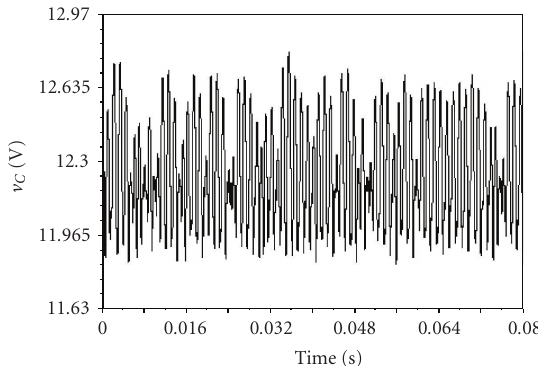
Figure 8: 2- T subharmonic operation. ( E = 37 . 5 V): phase plane.